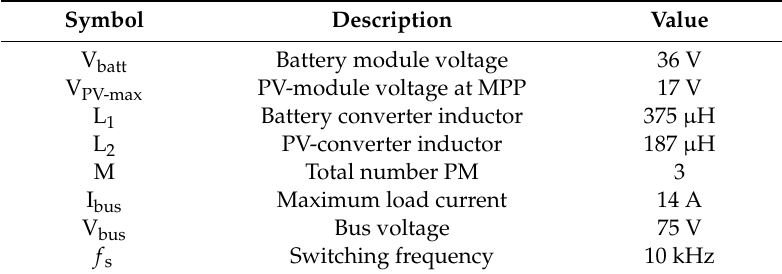
Table 1. Design parameters of the experimental setup.